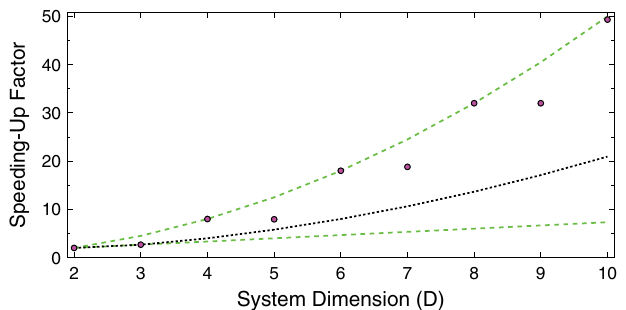
FIG. 14. The asymptotic speeding-up for reaching a given level of purity as a function of the system dimension. The dashed green lines are the upper and lower bounds on all unbiased-basis purification strategies, i.e., Eq. (15). The dotted black line is the maximum achievable speeding-up for the QFT protocol, i.e., Eq. (31). The solid circles are the results of a numerical search over unbiased bases to maximize the asymptotic speeding-up. See the text for more details.